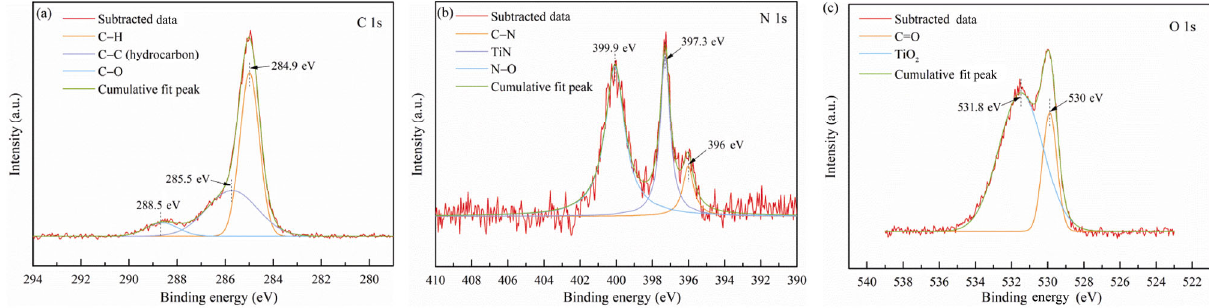
Fig. 11 XPS spectra of the worn surface of TiN–Ag (10 at%) with fitting peaks (voltage: 1.5 V; load: 15